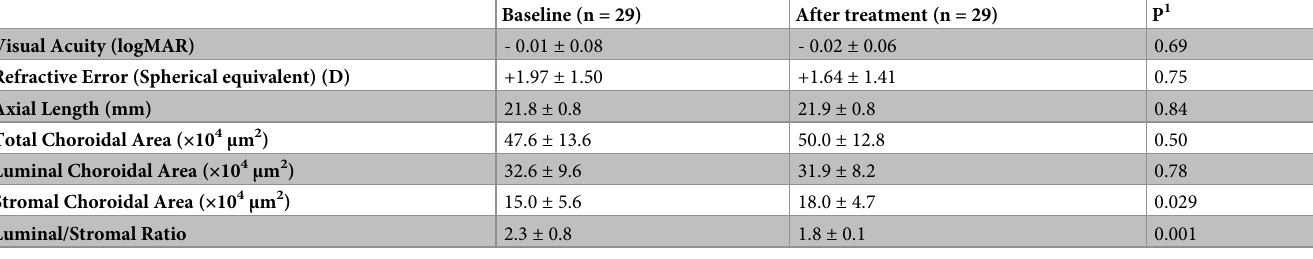
Table 2. Data of the fellow eye of the amblyopic patients before and after one-year optical treatment.